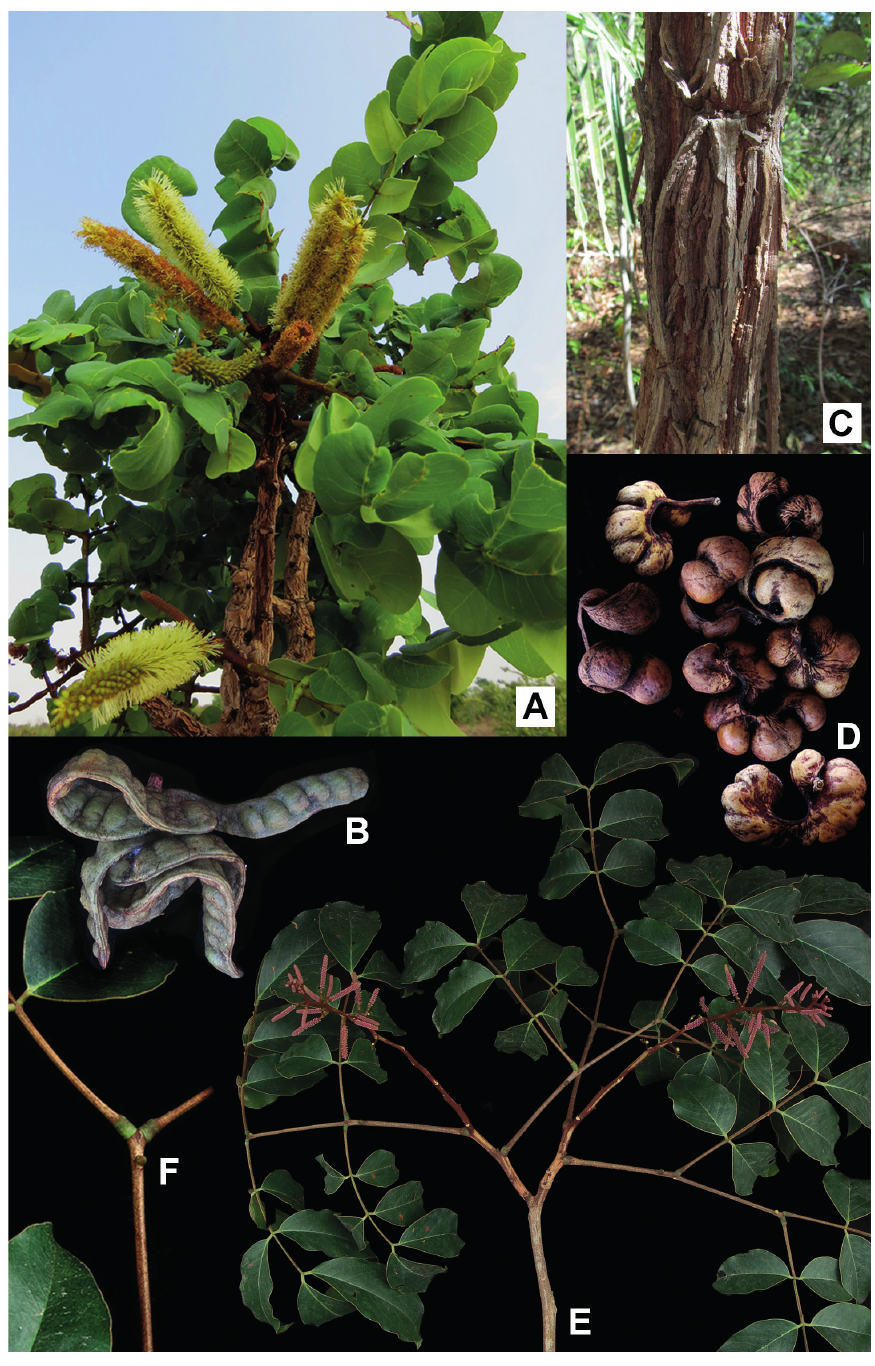
Figure 4. A, B Gwilymia coriacea : A flowering branch B fruit C, D G. fissurata : C detail of bark D fruit E, F G. paniculata : E flowering branch with young inflorescences F detail of the extrafloral nectary on the leaf rachis. Photos: Marcelo